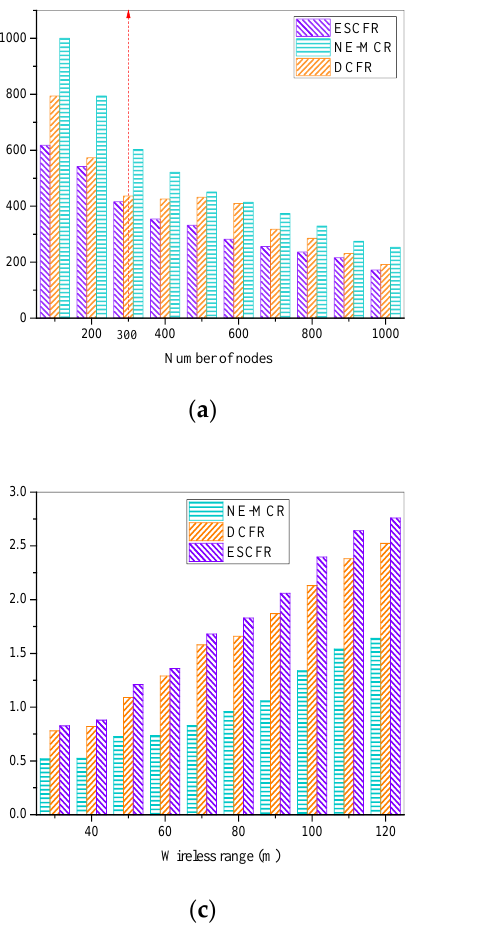
Figure 12. Simulation results for energy efficiency considering: ( a ) ADT versus network density; ( b ) energy consumption versus network density; ( c ) energy consumption versus wireless range; ( d ) ADT versus wireless range.